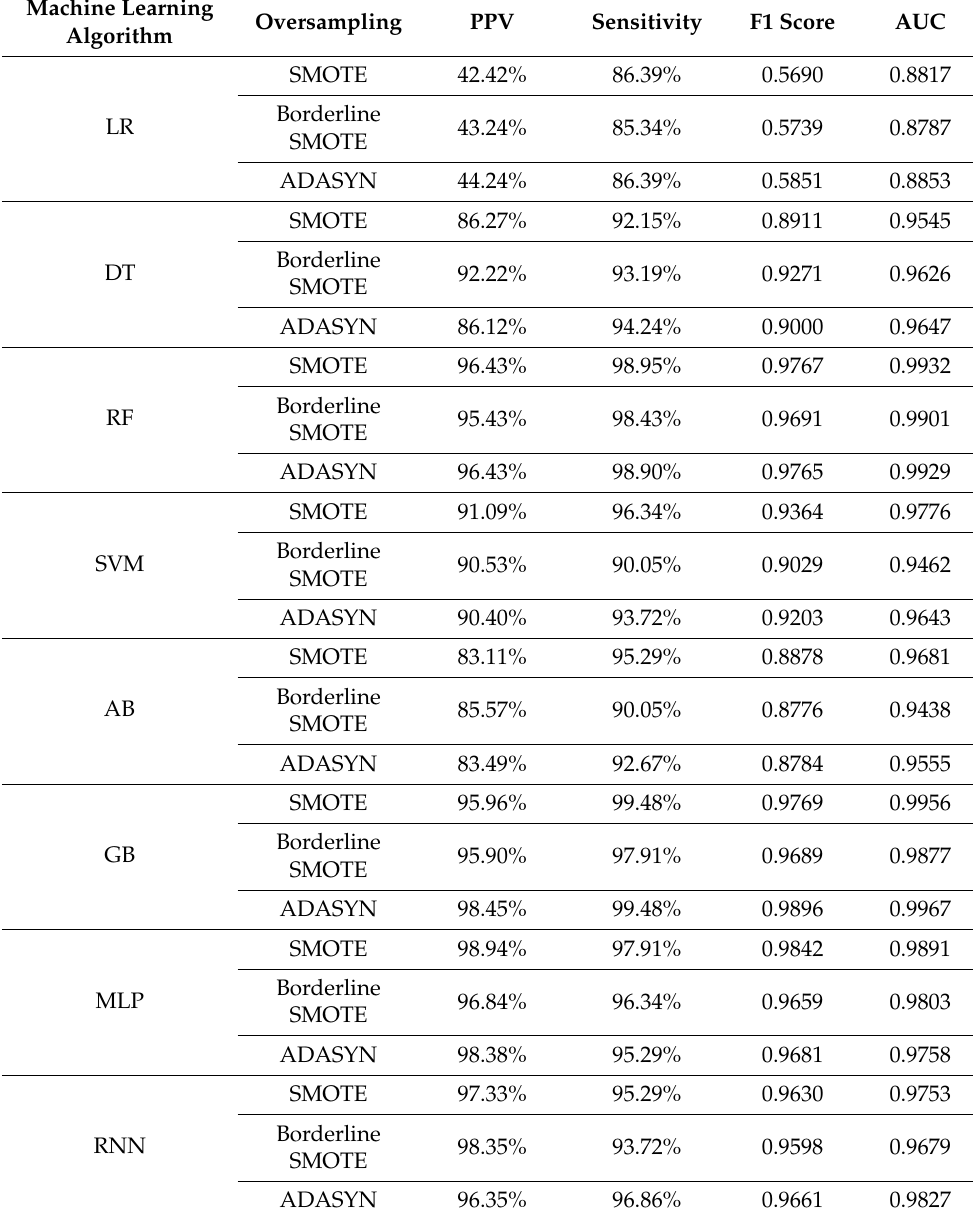
Table 9. Prediction performance. GRU with ADASYN demonstrated the highest